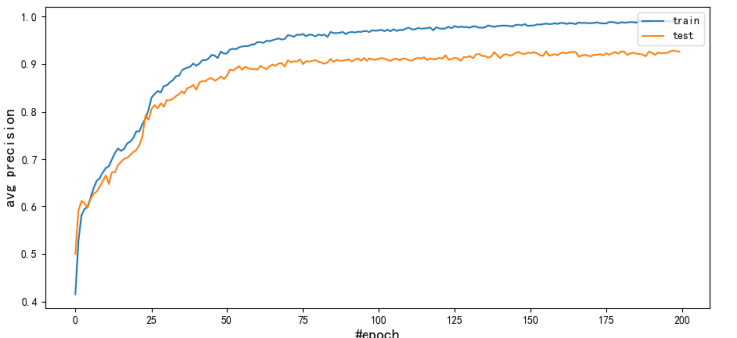
Figure 11. The change of average precision value of each label category with training